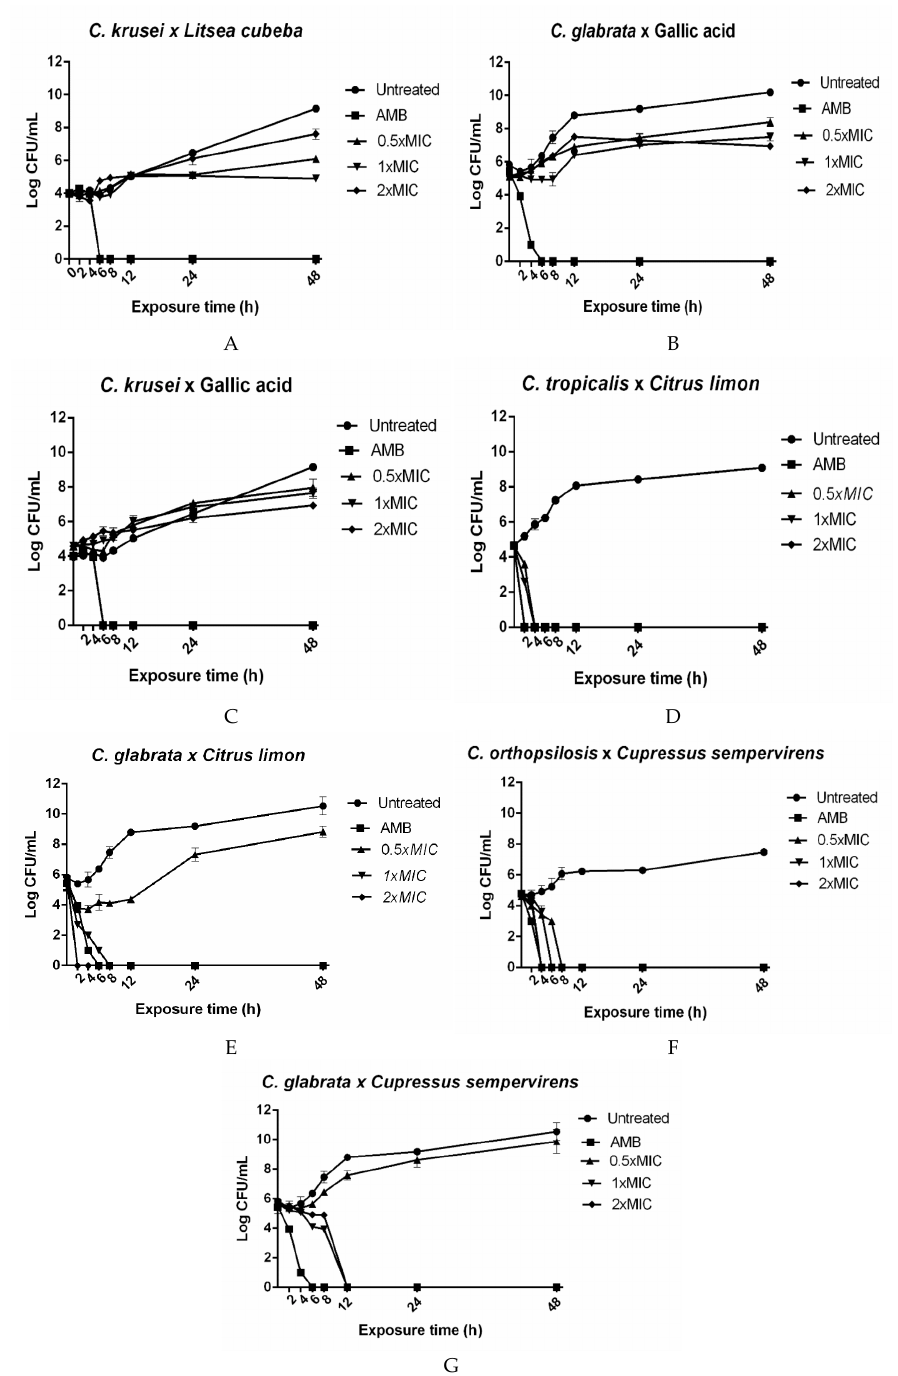
Figure 1. Kill assays for plant-derived products against Candida species. The concentrations 0.5 × MIC, 1 × MIC, and 2 × MIC correspond to: ( A ) Litsea cubeba × C. krusei : 31.25, 62.5, and 125 µ g / mL; ( B ) Gallic acid × C.glabrata 31.25, 62.5, and 125 µ g / mL; ( C ) Gallic acid × C. krusei : 62.5, 125, and 250 µ g / mL; ( D ) Citrus limon × C. tropicalis : 125, 250, and 500 µ g / mL; ( E ) Citrus limon × C. glabrata : 125, 250, and 500 µ g / mL; ( F ) Cupressus sempervirens × C. orthopsilosis: 15.62, 31.25, and 62.5 µ g / mL; ( G ) Cupressus sempervirens × C. glabrata : 15.62, 31.25, and 62.5 µ g / mL. AMB: 4 µ g / mL amphotericin B and Untreated: Candida species’ growth without plant-derived products. The results are expressed as the mean colony-forming units (CFU) / mL ± standard deviation from three independent